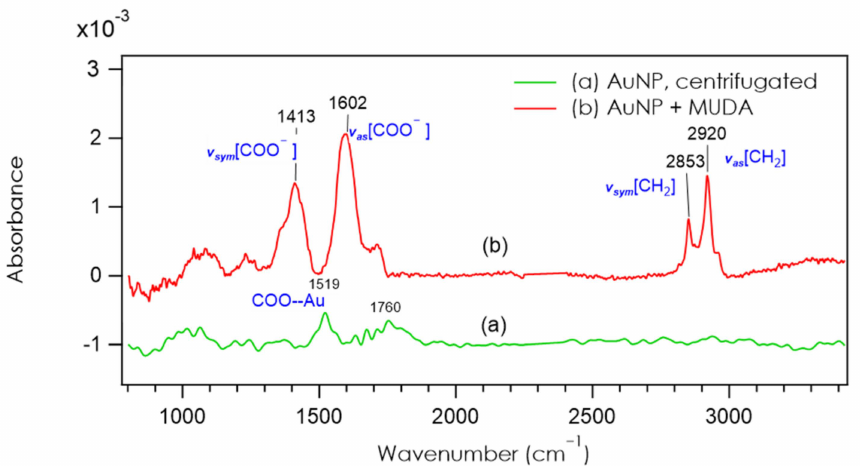
Figure 2. FTIR (Fourier Transform Infra-Red) absorption spectra of two AuNPs solutions, centrifu- gated and dropcasted on a silicon substrate, recorded in transmission with 70 ◦ incidence. Spectrum ( a ) corresponds to the Turkevich solution after centrifugation and spectrum ( b ) corresponds to the AuNP solution after functionalization with